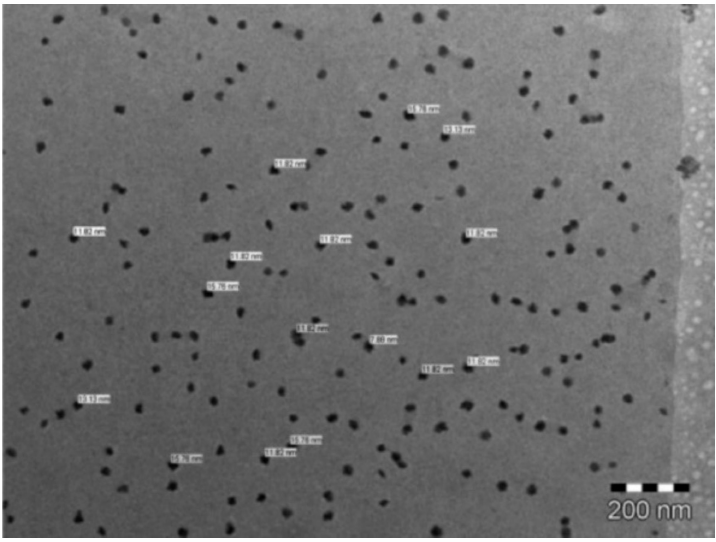
Figure 9. TEM image of the micelles obtained from aqueous solution of PDLLA42-b-PNVP63. Obtained from reference [147]. Copyright @ 2012 Elsevier, License Number: